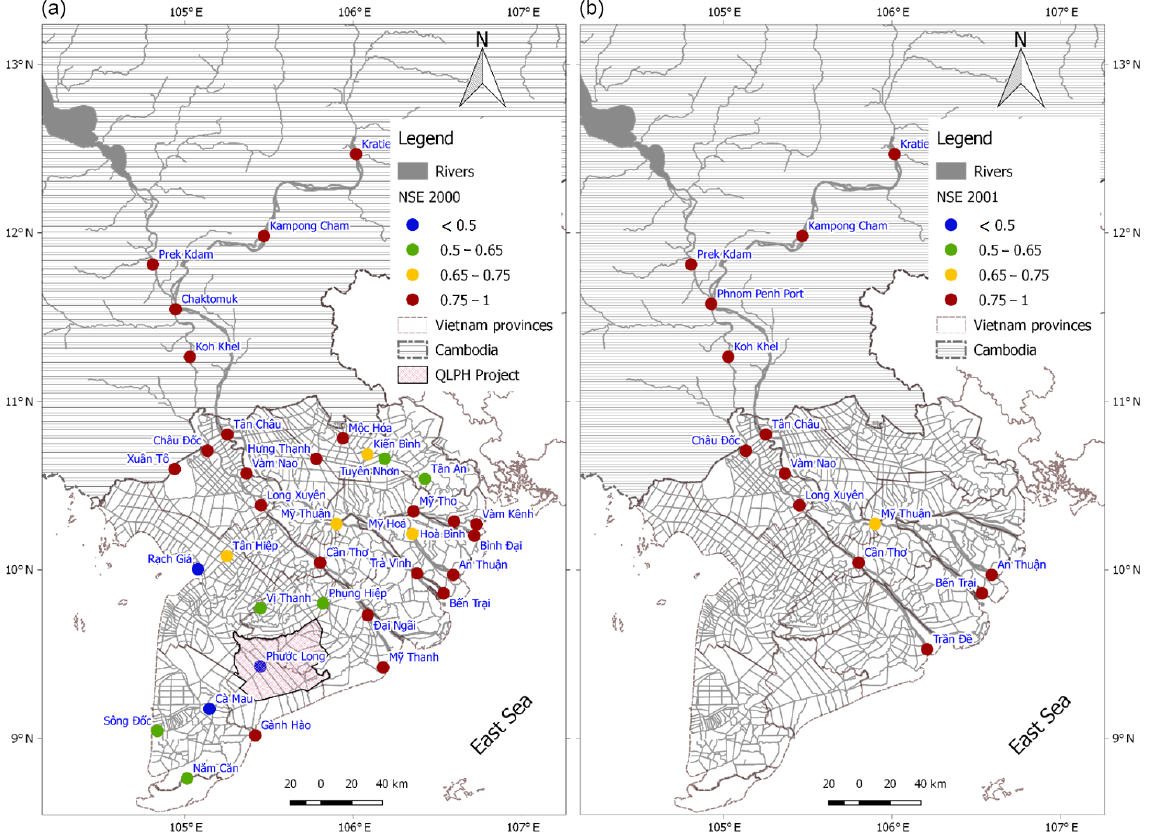
Figure A1. The NSE values of the water levels at the gauging stations in the Mekong Delta. The calibration (the year 2000) and validation (the year 2001) are presented in panels (a) and (b)